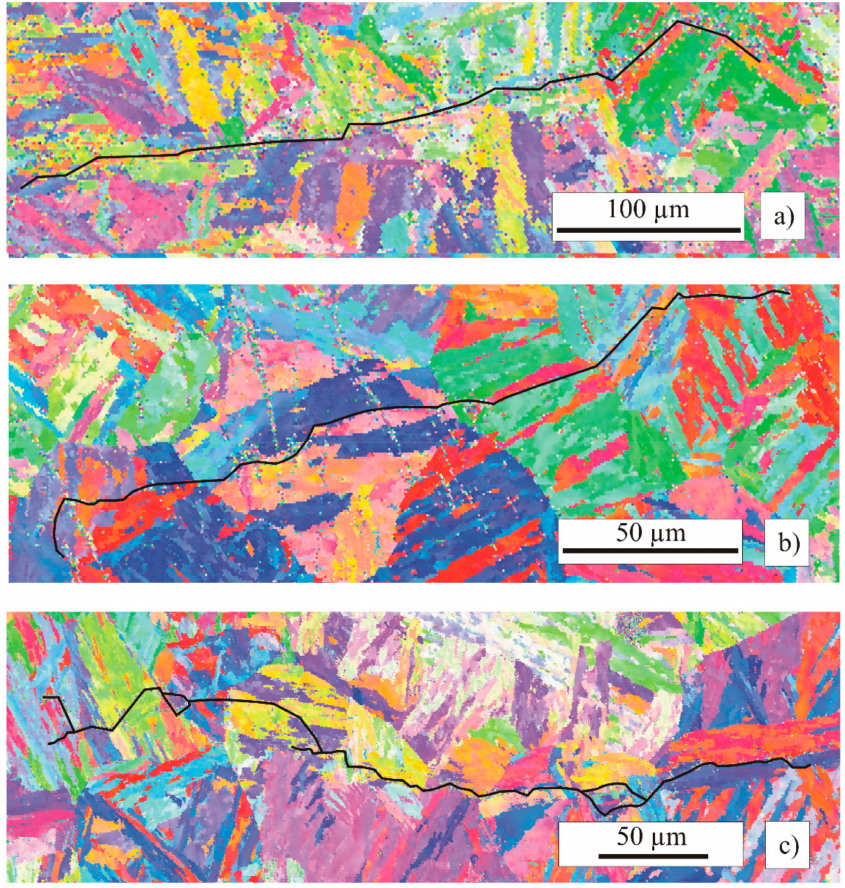
Figure 11. EBSD scan of X3 specimen: ( a ) in vacuum (75.000 cycles), ( b ) at laboratory air (50.000 cycles) and ( c ) precharged (40.000